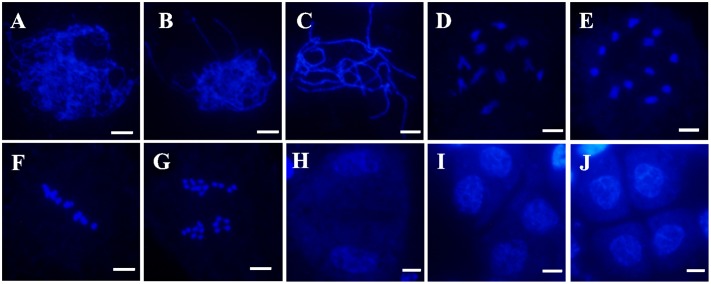
4′,6-diamidino-phenylindole (DAPI)-stained chromosome spreads of male meiosis in WT plants. (A) Leptotene. (B) Zygotene. (C) Pachytene. (D) Diplotene. (E) Diakinesis. (F) Metaphase I. (G) Anaphase I. (H) Dyad. (I) Telophase II. (J) Tetrad. Bars = 5 μm.